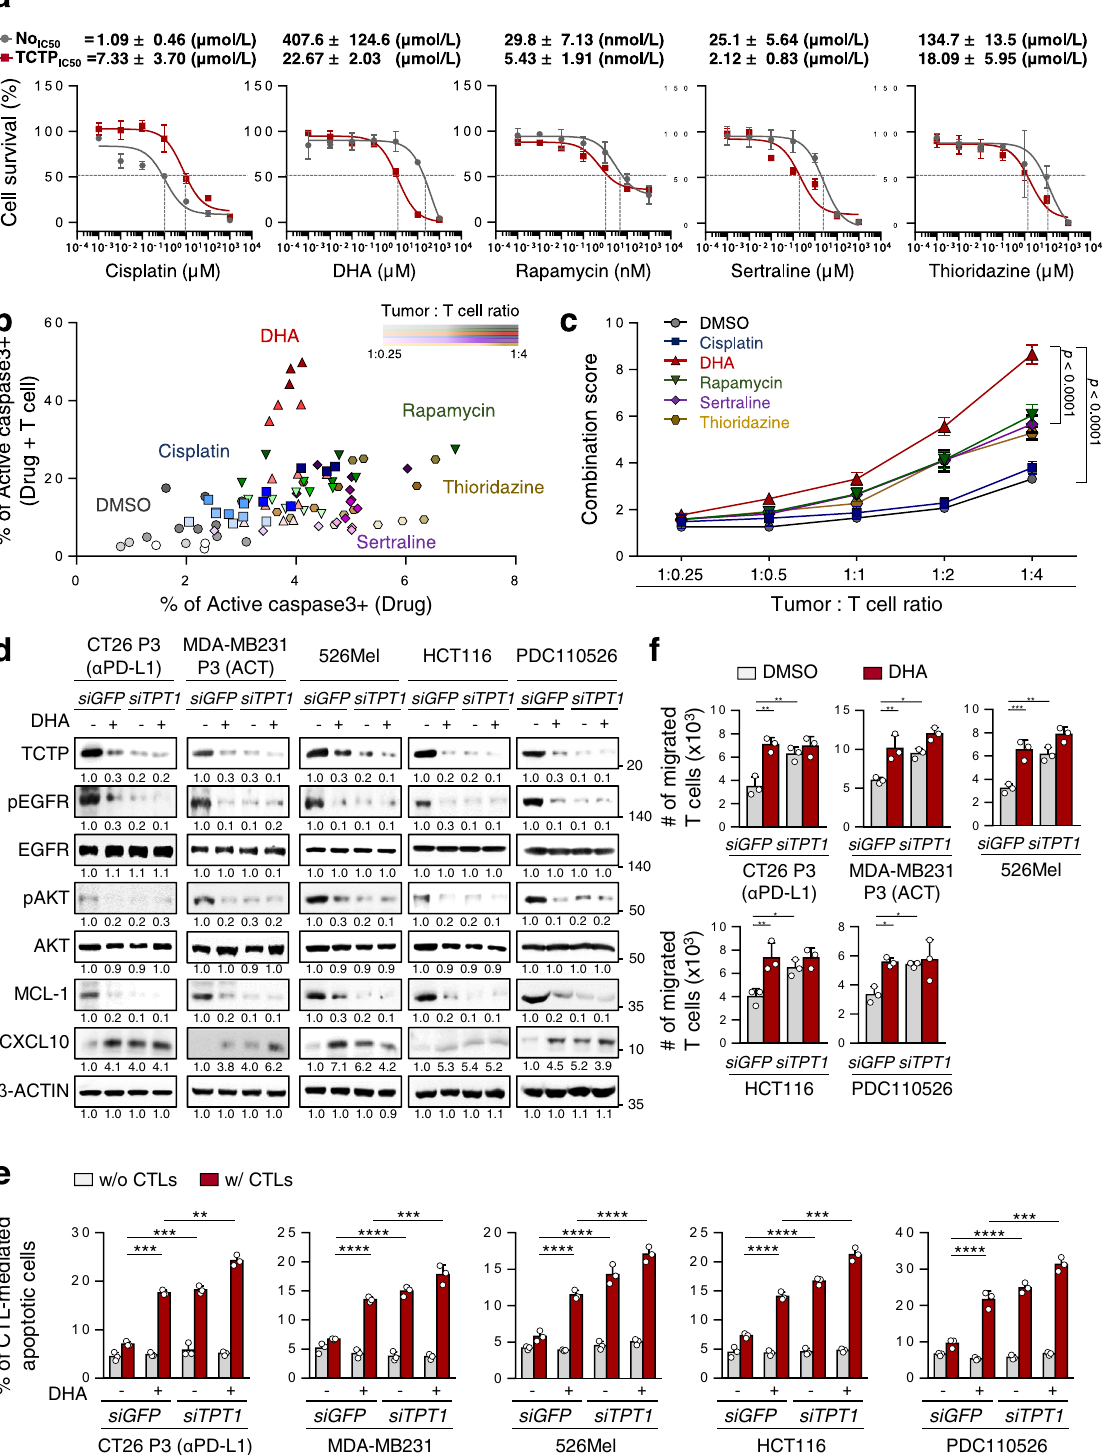
tumor. This means that tumor cells evolved during T cell-medi- ated therapy not only evade the CTL-mediated lysis but also reversely restrict anti-cancer immunity via blocking T cell traf- fi cking to the tumor. Taken together, our study revealed that the crucial dual role of the TCTP axis of tumor cells at the crossroads between tumor cells and the anti-cancer immunity system to potentiate resistance to T cell-mediated